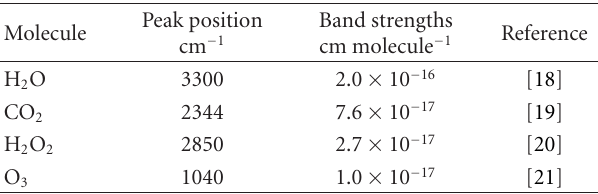
Table 2: Peak positions (cm − 1 ) of the bands used to evaluate the column density of the given species and the band strengths (cm molecule − 1 ).